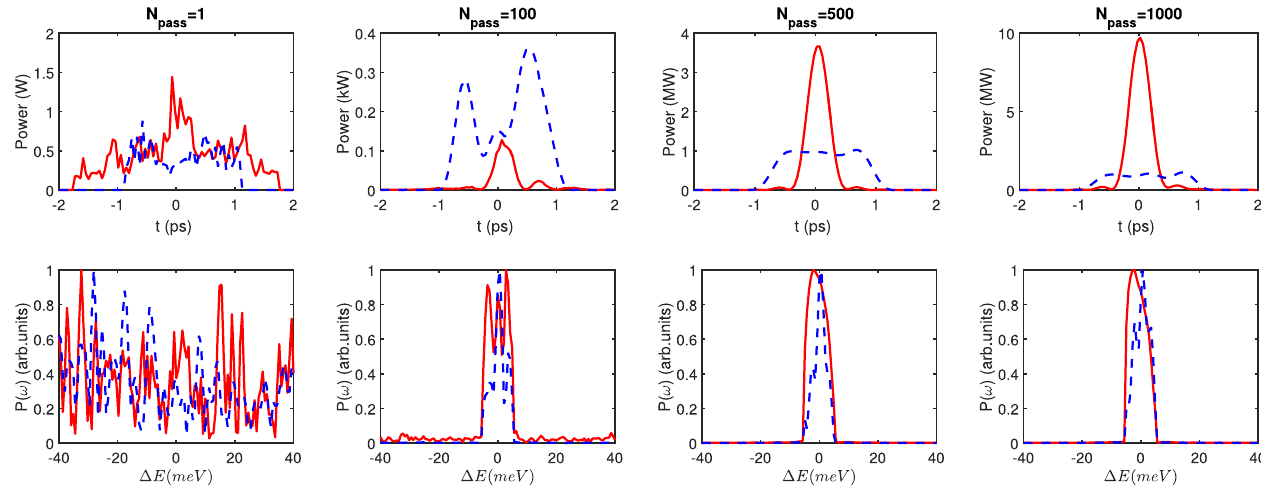
FIG. 6. The temporal and spectral profile of the output 1 Å pulse in the normal FEL oscillator (blue dashed line) and four-stage undulator cascaded FEL oscillator (red solid